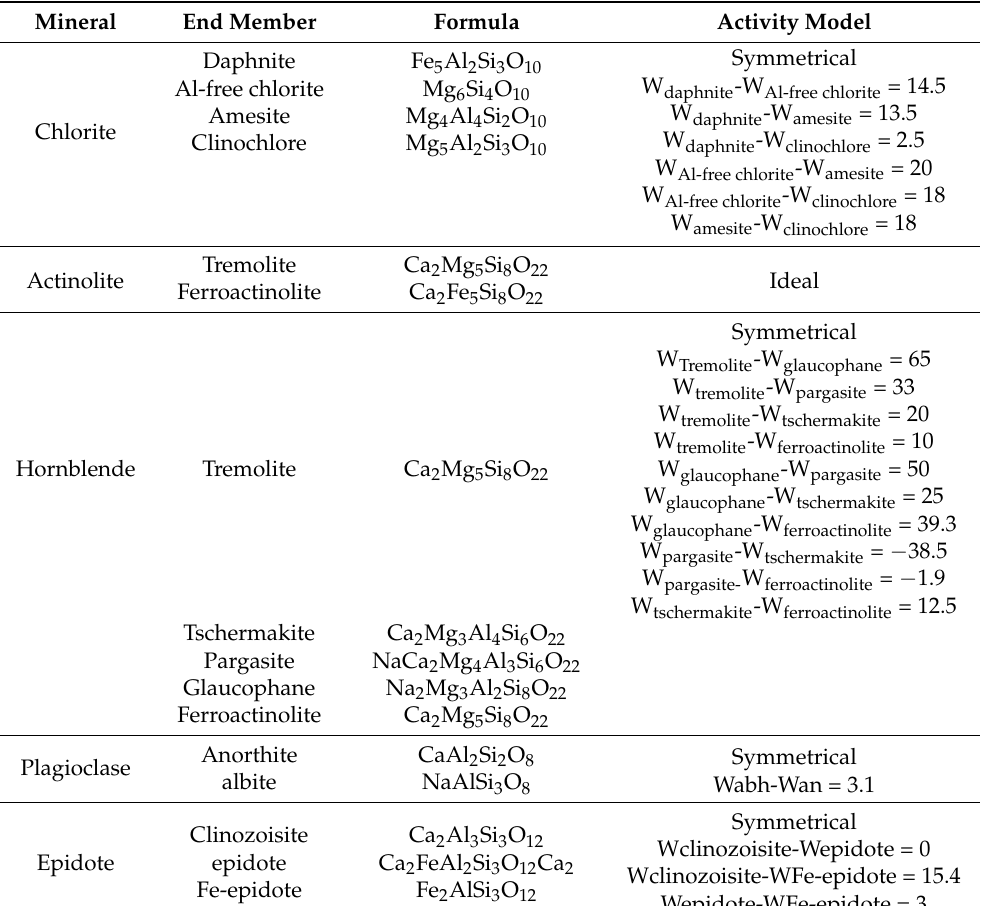
Table A5. Solid solutions included in the modeling of altered marine basalt. The thermodynamic properties of end members are from Holland and Powell [19] and Dale et al. [45].